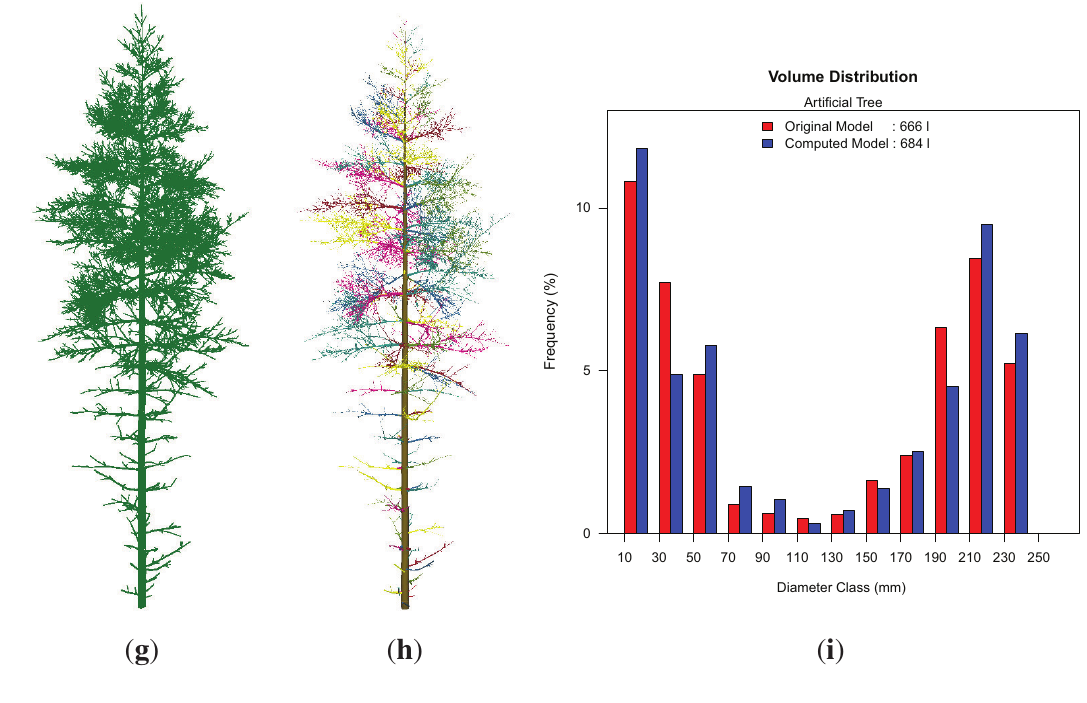
Figure 10. Visualization of the artificial tree results (height ≈ 18 m): (g) artificial point cloud; (h) resulting cylinder model with branches colored differently; (i) volume distribution in both the original data and program results.